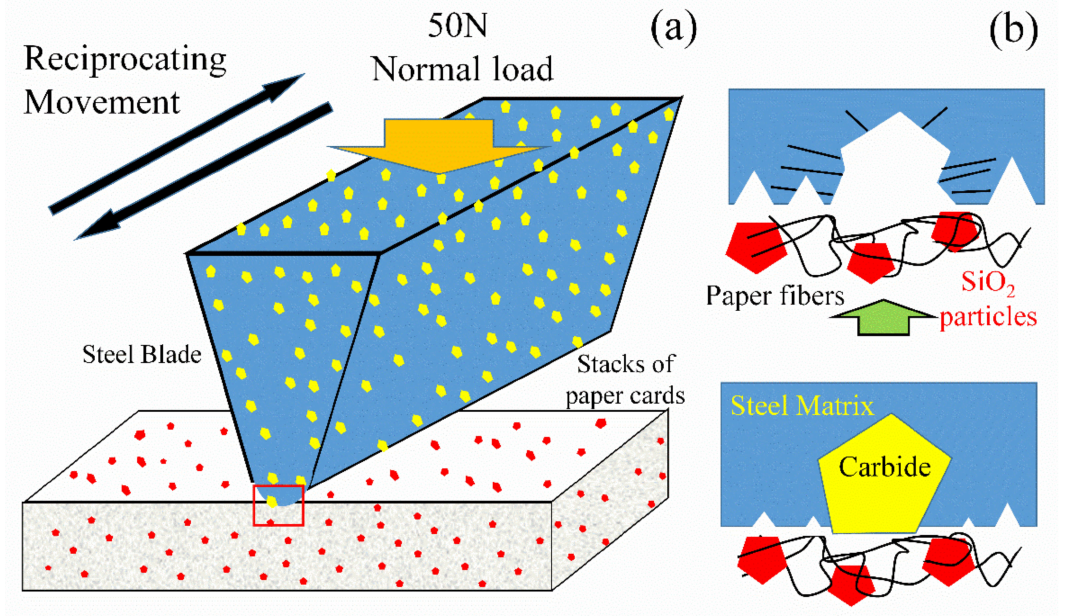
Figure 12. Schematic diagram ( a ) for a possible wear mechanism of steel blade edge, and the enlarged view of blade tip ( b ) displays small scratches on the steel matrix in the presence of carbides, while the cracks and deep abrasive grooves appear in steel matrix after the carbides peel off due to cooperation of abrasive wear and fatigue wear in the sharpness